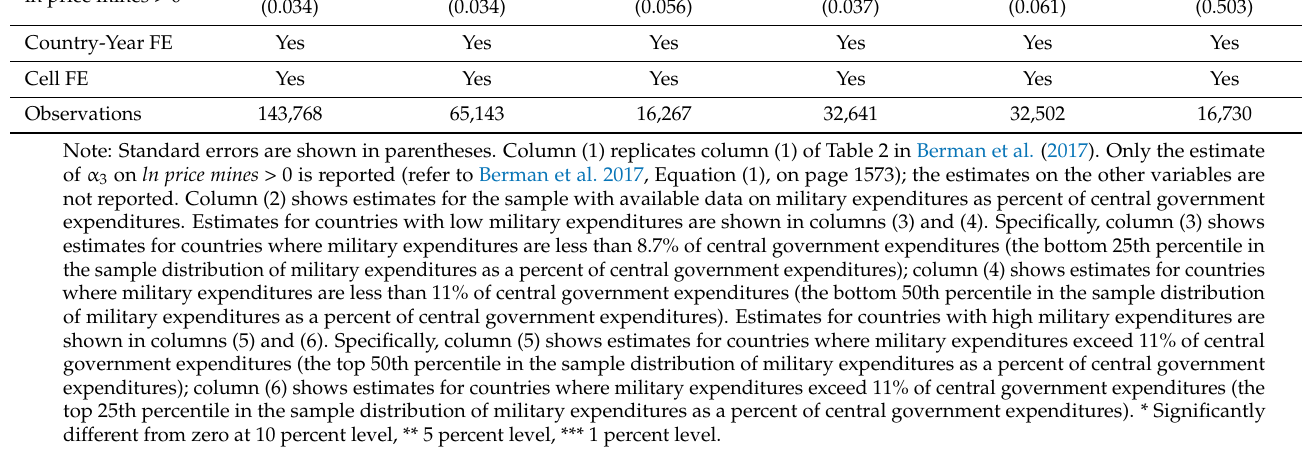
Table A6. Cotet and Tsui (2013, AEJ Macro) “Oil and Conflict”. Fixed Effects OLS